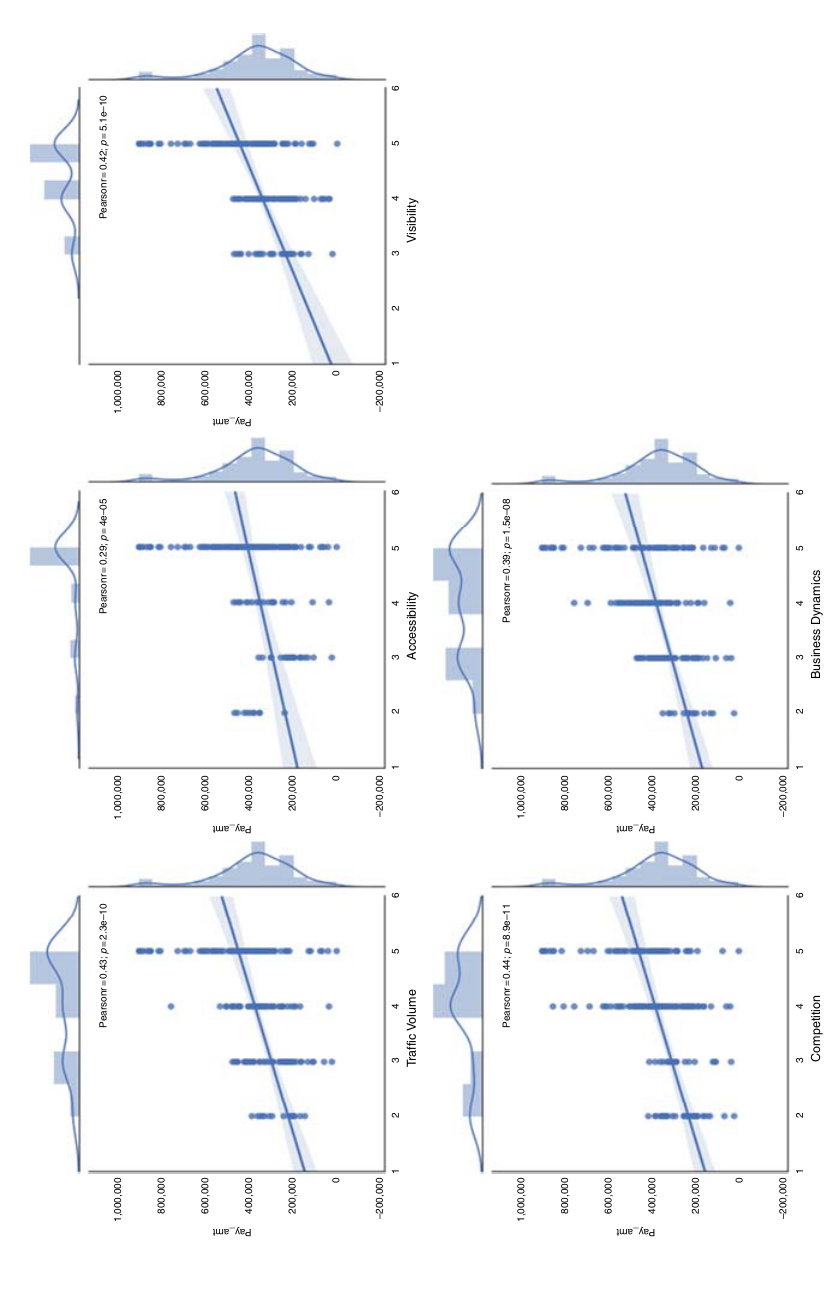
Figure 3. Relationship between sales and the five